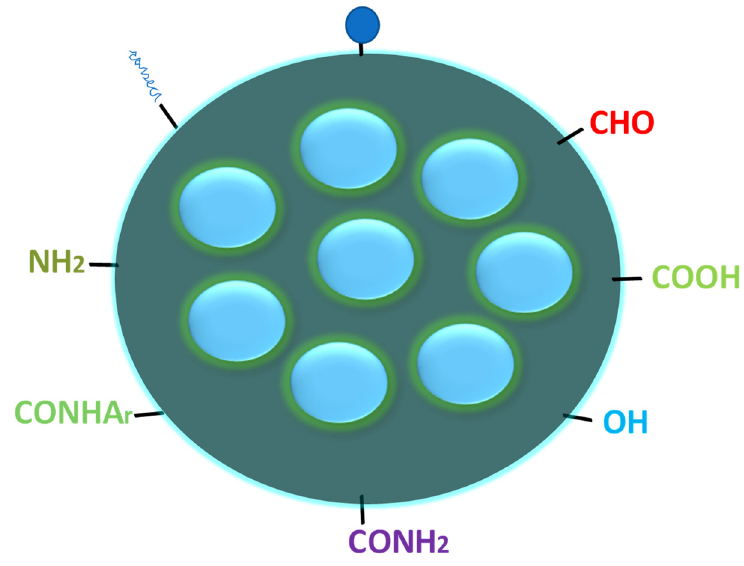
Figure 3. Typical structure of CQDs with different functional groups on the surface.